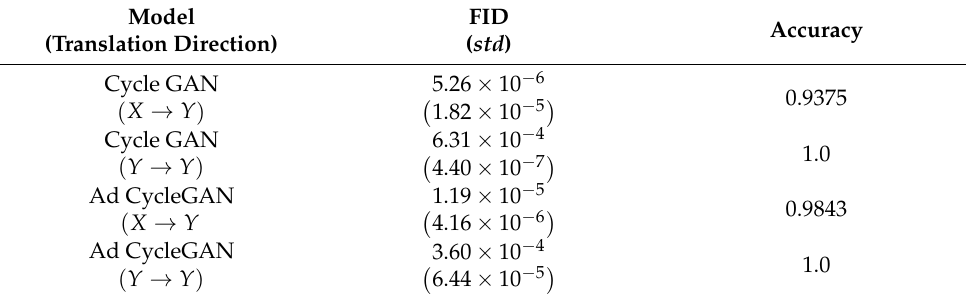
Table 2. FID score and classification